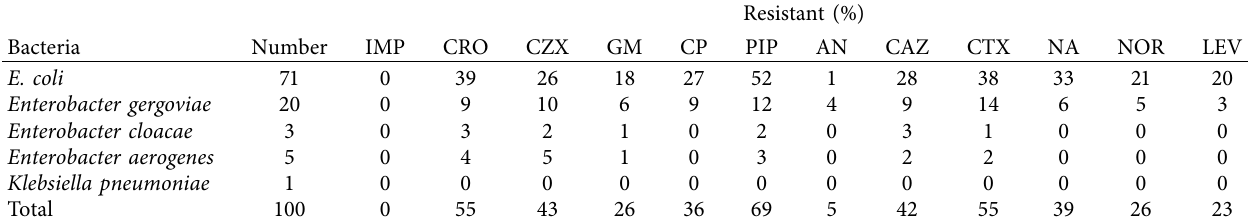
Table 2: The results of the antibiogram test for Enterobacteriaceae